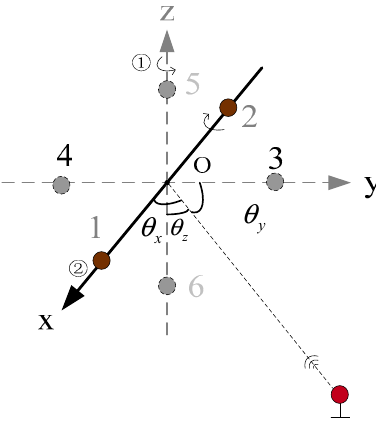
Figure 8. The rotation diagram of the USBL acoustic array